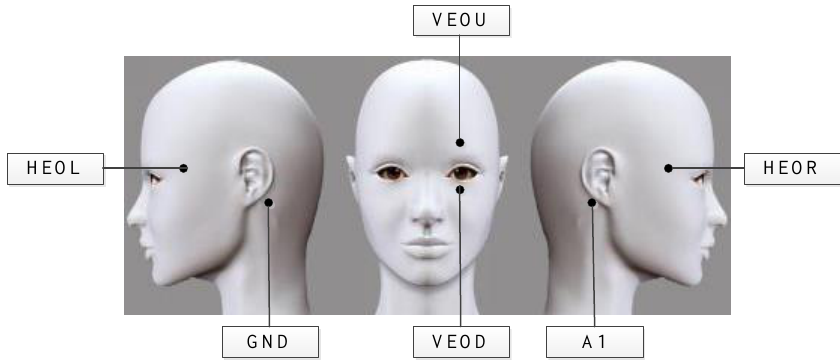
Figure 3. Demonstration of electrodes distribution.